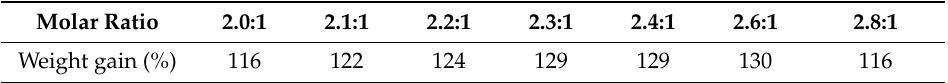
Table 3. CO 2 absorption performances of Li 4 SiO 4 materials with different molar ratios of Li 2 CO 3 to SiO 2